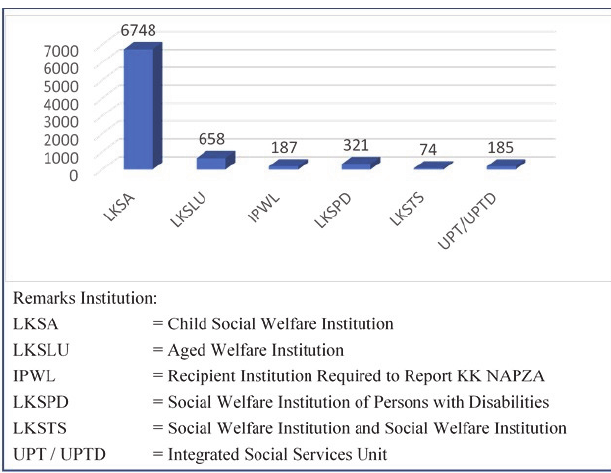
Fig. 1. Social Welfare Institutions in